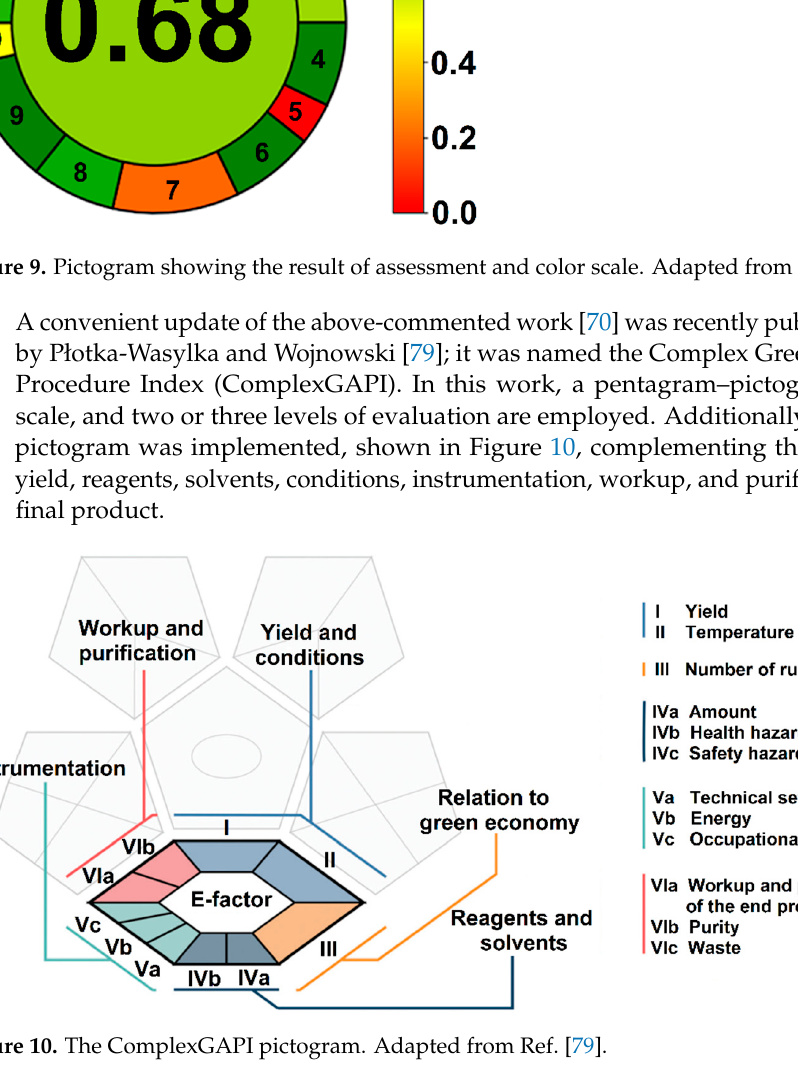
Figure 10. The ComplexGAPI pictogram. Adapted from Ref. [79].